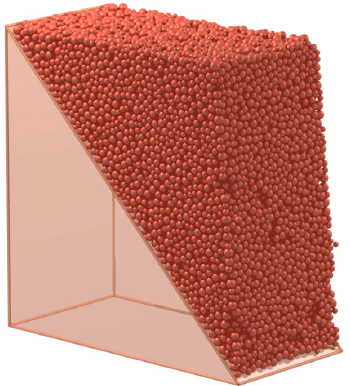
Figure 12. The section of the rock slope with parallel fractures and its size.